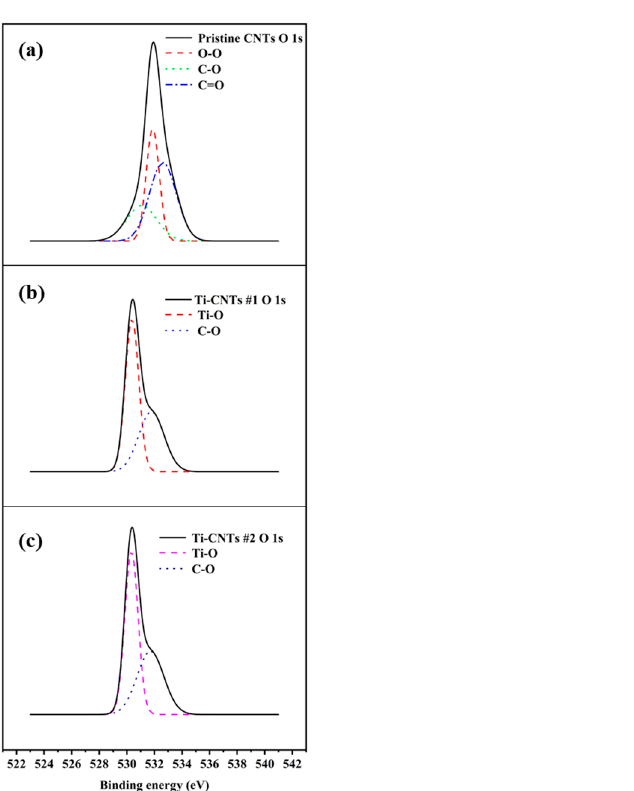
Figure 4. The XPS spectra of O 1 s states of ( a ) pristine CNTs, ( b ) Ti-CNT #1, and ( c ) Ti-CNT #2.